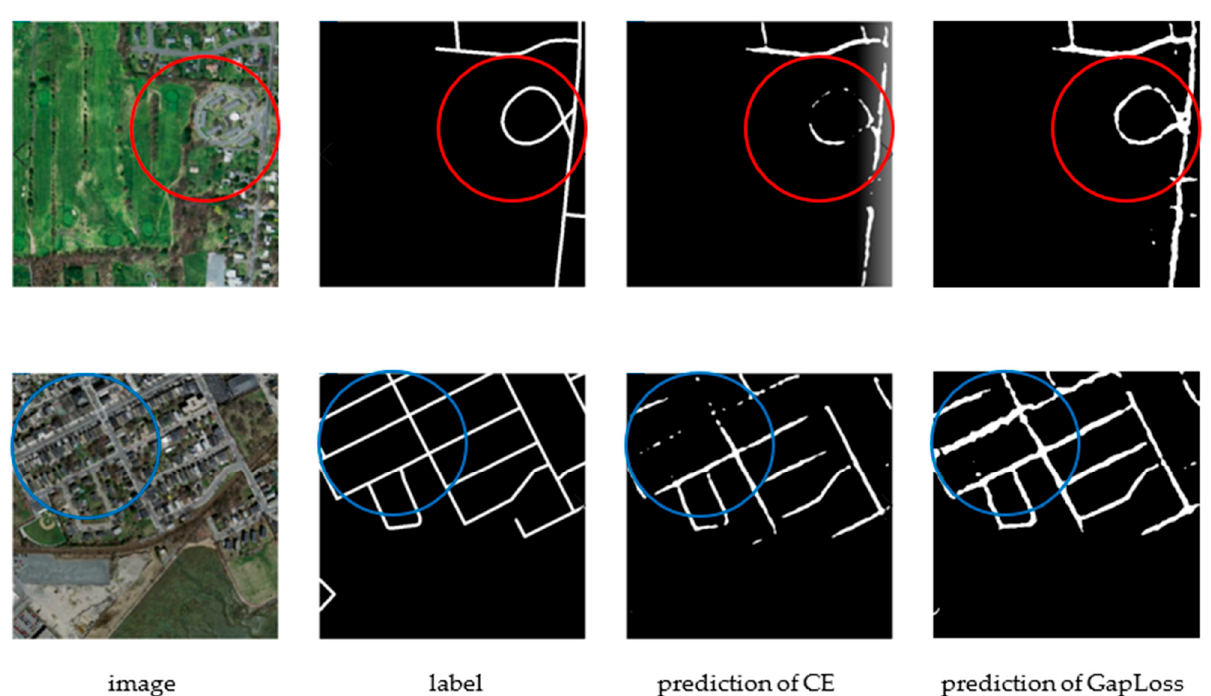
Figure 2. SegNet results with CE and GapLoss on Massachusetts Roads Dataset. The blue and red circles indicate where the road continuity is improved after using GapLoss.